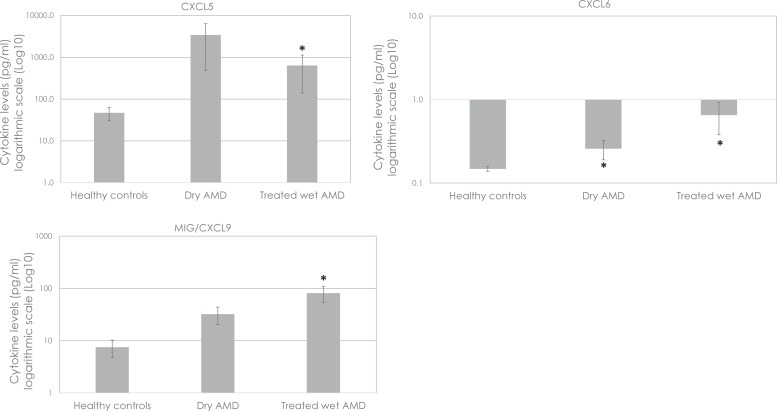
Mean concentrations (pg/ml) of the three cytokines/chemokines CXCL5, CXCL6 and MIG/CXCL9 in the aqueous humor of patients with either dry age-related macular degeneration (AMD) or treated wet AMD showing relevant differences (*, p<0.0012) in their levels when compared to healthy controls.Whiskers represent the standard error of the mean. Values are represented on a logarithmic scale.